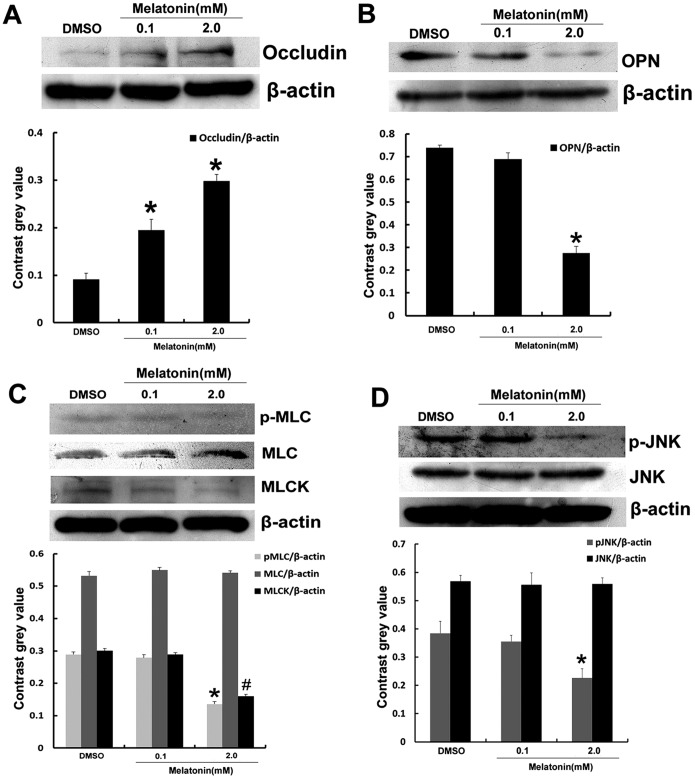
Effect of melatonin on the expression of occludin, OPN, MLCK and phosphorylation of MLC, JNK.(A) occludin, (B) OPN, (C) MLC and MLCK, (D) JNK. Results are presented as mean ± SD of three independent experiments. *P<0.05, in comparison to control group.